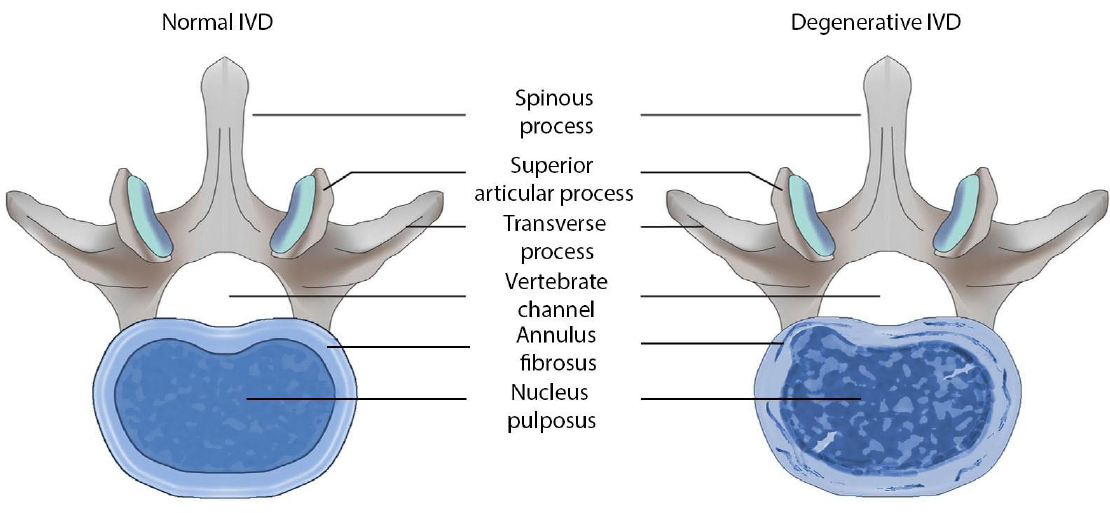
Figure 1. Schematic representation of the human lumbar intervertebral disc (IVD) in normal conditions and with its degeneration.